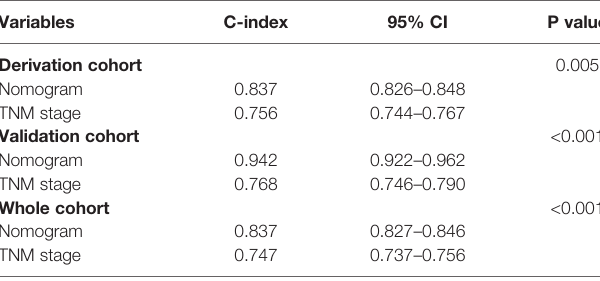
TABLE 5 | Comparison between nomogram and TNM classi fi cation in LSCC.